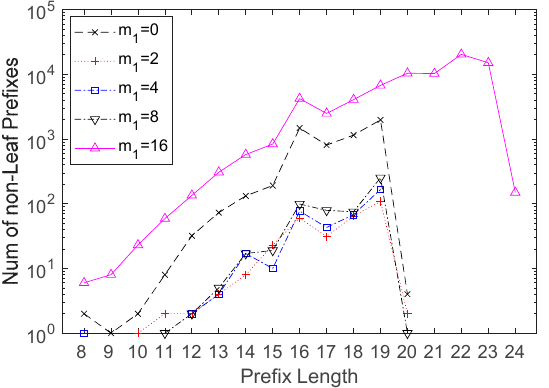
Figure 12. The number of non-leaf prefixes with a BF 1 size m 1 in log scale.